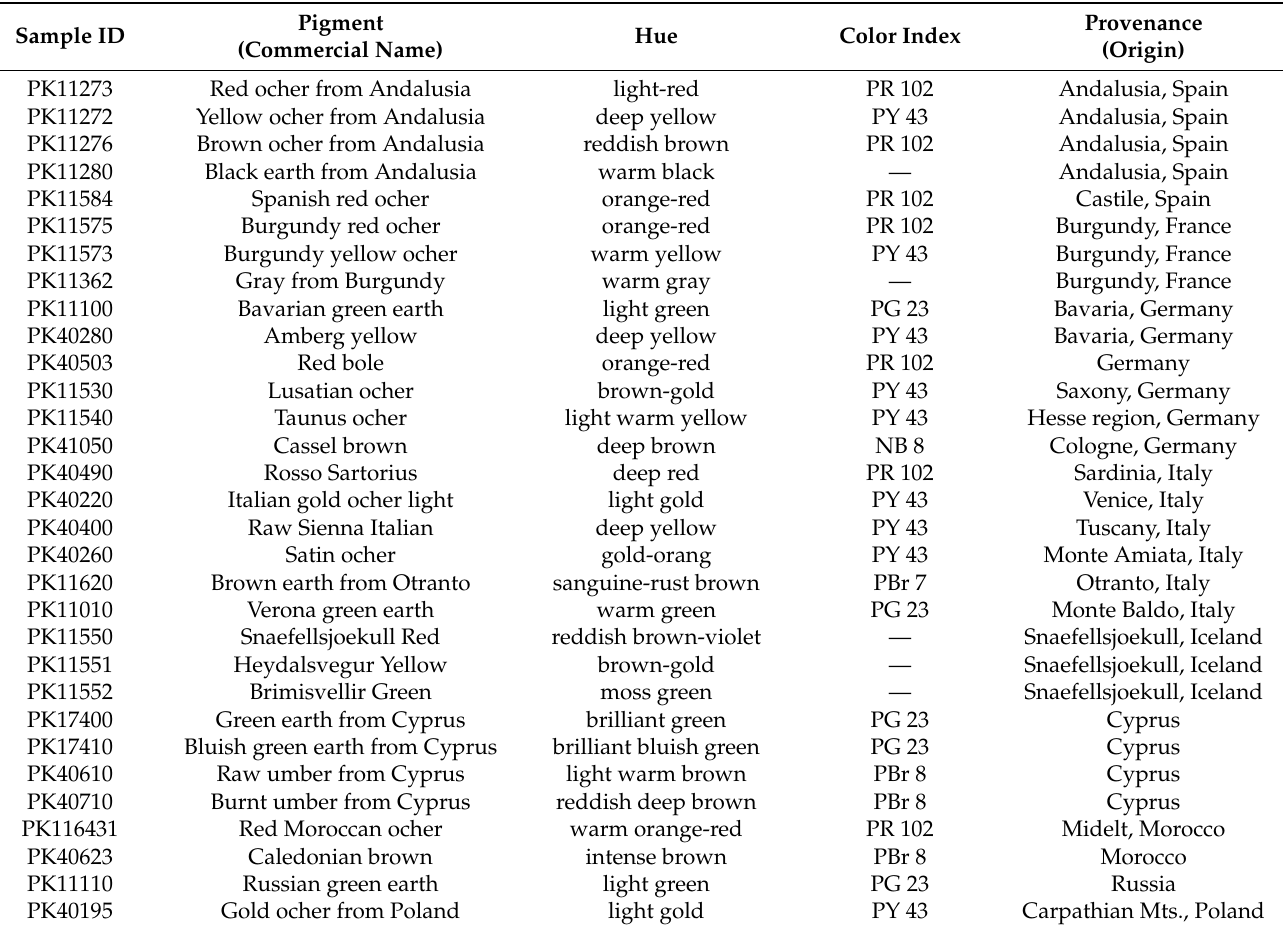
Table 2. Pigments investigated in this study. Pigments, obtained from Kremer Pigmente, are denoted by PK, followed by the catalog